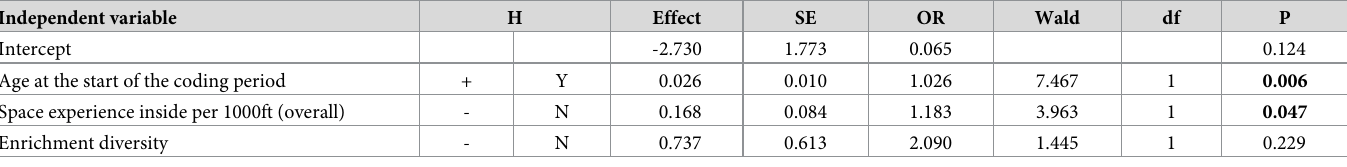
Table 17. Multivariate Poisson regression of factors associated with the number of foot lesions experienced by individual elephants that experienced at least one event (n = 61). Hypotheses (H): positive (+) or negative (-) relationship of each variable with the number of clinical events per animal as a measure of elephant welfare, and whether observed relationships were in the predicted direction (Y yes / N